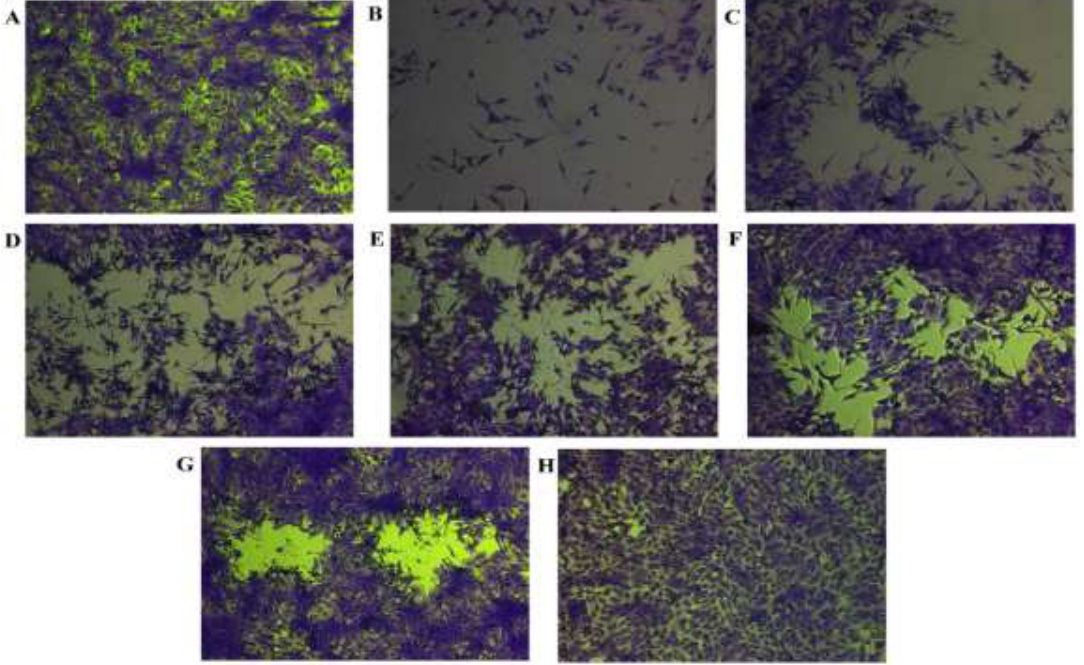
Figure 5: The cytopathic effect of the NDV on Vero cell lines by utilizing the virus titration (TCID 50 ). (A) Control not infected cells, (B) infected with the first dilution of NDV; (C) infected with the second dilution of NDV; (D) infected with the third dilution of NDV; (E) infected with the fourth dilution of NDV; (F) infected with the fifth dilution of NDV; (G) infected with the sixth dilution of NDV; and (H) infected with the seventh dilution of